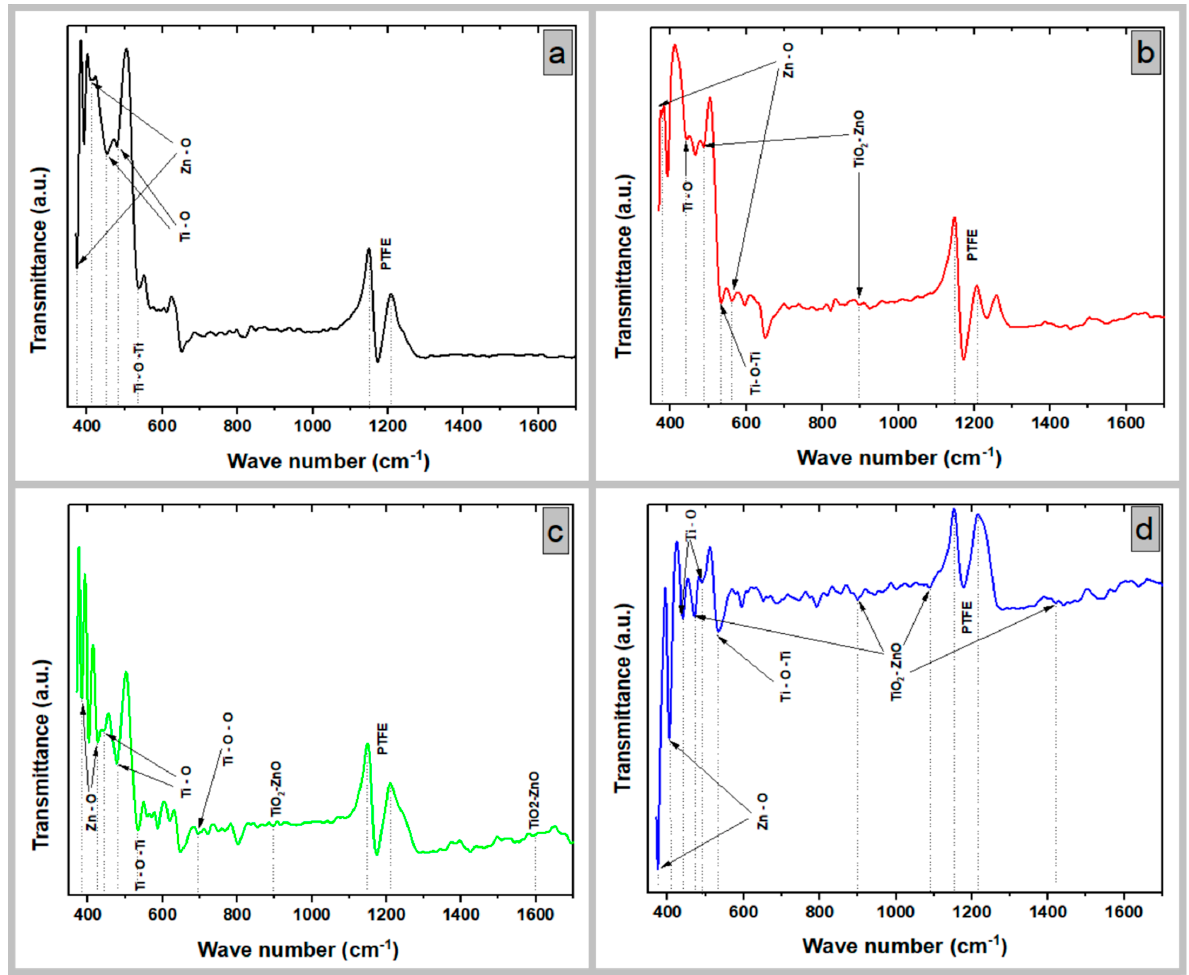
Figure 7. FTIR spectra for the synthesis of nanocomposites on PTFE substrates: ( a ) S 1 , ( b ) S 2 , ( c ) S 3 , and ( d ) S 4 .